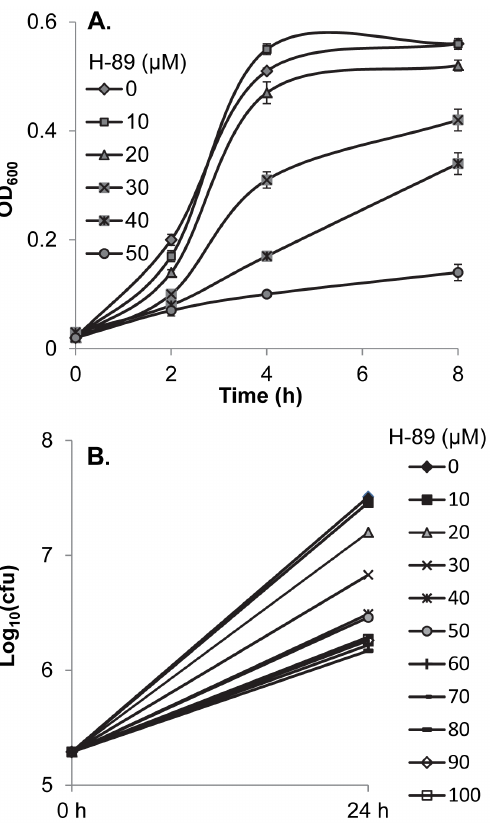
Figure 3. Effect of H-89 treatment on nitric oxide (NO) production in S . Enteritidis-infected HD11 cells and the intracellular survival of S . Enteritidis. A. Effect of H-89 treatment on NO production in S . Enteritidis-infected HD11 cells. HD11 cells were infected with live S . Enteritidis (SE) for 1 h in 24-well plates at 39 u C in a 5% CO2 humidified incubator. At 1 hour post infection (hpi), extracellular SE were killed by incubation with media containing 100 m g/mL of gentamicin sulfate for 1 h; the cells were washed and then cultured in media containing various concentrations of H-89 and 20 m g/mL of gentamicin sulfate for an additional 22 h; and nitrite contents in cell culture media were determined. Treatment with heat- killed S . Enteritidis (HKSE) was performed identically as with live SE. B. HD11 cells were infected with live SE as described above and at 24 hpi, intracellular viable SE [Log10 (cfu)] were counted. The symbol (*) indicates that the difference between these groups and the respective controls is statistically significant (p , 0.05).